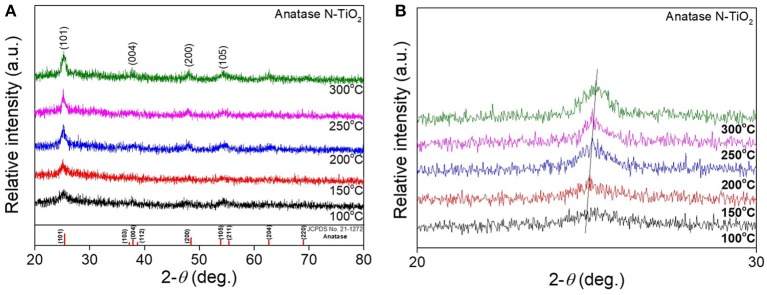
XRD analysis of (A) N-TiO2 nanoparticles at different calcination temperature and (B) an enlarged (101) peak.